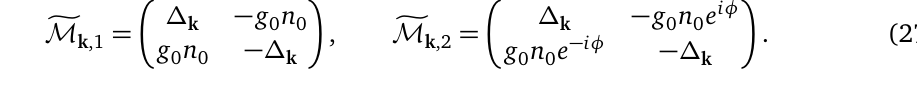
Figure 2: (a). The sine-wave periodic modulation of the scattering length. Here we set φ = π/ 3. (b). A density plot of | Tr ( U ( T )) | > 2 (heating phase) and ω for | Tr ( U k The dashed line denotes the phase boundary, where | Tr ( U